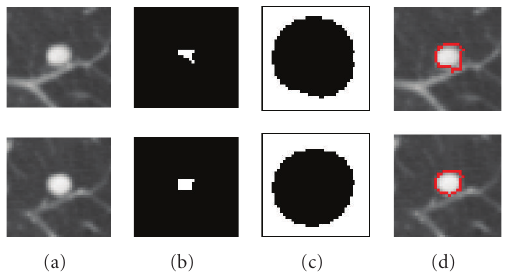
Figure 4: An example of the segmentation of an attached solid nodule based on the automatic calculation of the initial foreground and background. (a) 3D nodule in two contiguous CT slices; (b) initial foreground based on high spherical concentration; (c) initial background; (d) segmentation results by the proposed graph cut based